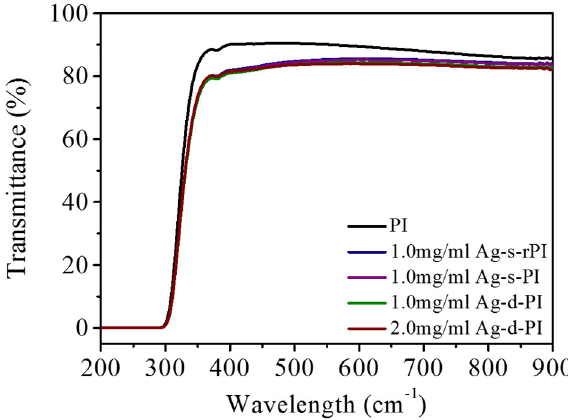
Figure 2. The transmittance of Ag/PI composite alignment layers (Coated on glass substrate).